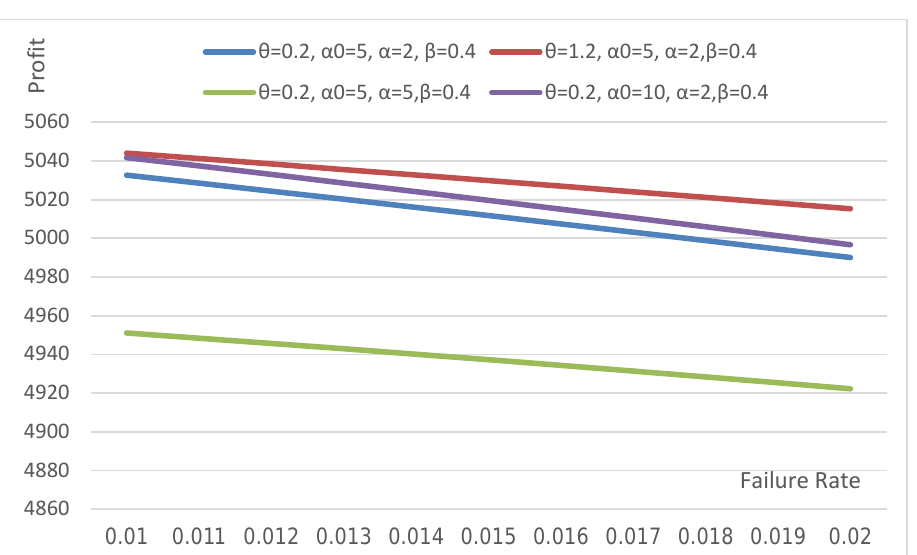
Fig. 3. Profit vs. Failure